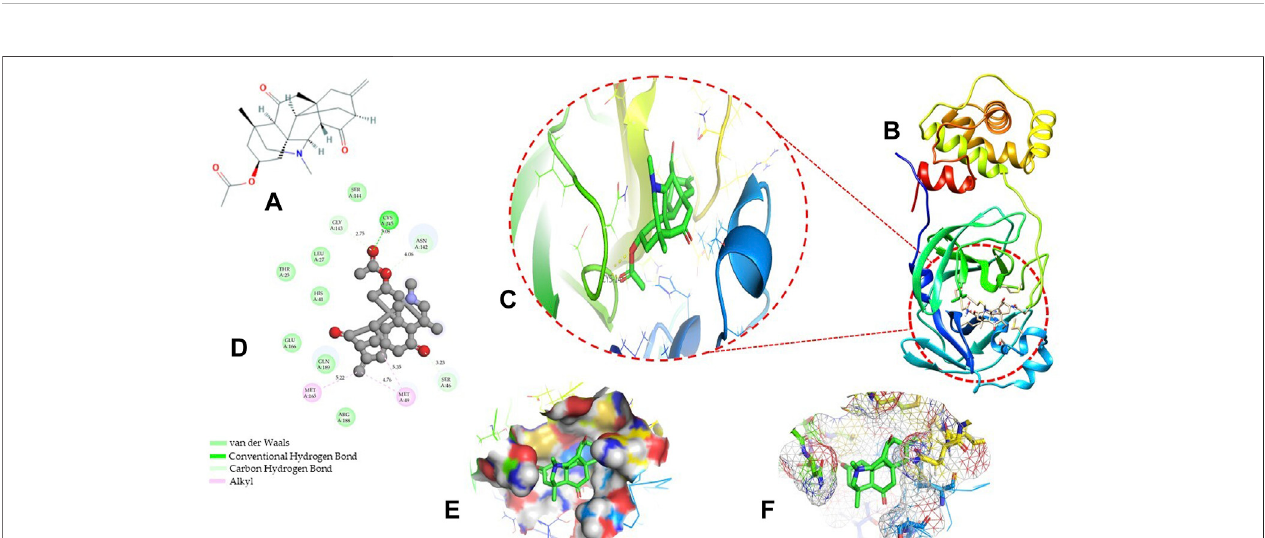
FIGURE2| Representationofmolecularinteraction betweenM pro and panicutine(CID_44566630)in2Dand 3Dmodes: (A) 2Dstructure ofpanicutine compound obtained from PubChem; (B) cartoon representation of the docking complex between M pro and panicutine molecule; (C) a close view of the pocket with docked panicutine which is shown as green sticks, M pro residues shown as atom-type color sticks, hydrogen bond represented as yellow dotted lines; (D) 2D plot of molecular interactions (van der Waals, conventional hydrogen bond, carbon – hydrogen bond, and alkyl) between panicutine and M pro ; (E) solid surface representation of pocket site; and (F) mesh surface view of pocket with panicutine in green sticks. The docking complex is rendered in 2D and 3D shapes using different protein visualization tools such as Discovery Studio, UCSF Chimera, and PyMOL.